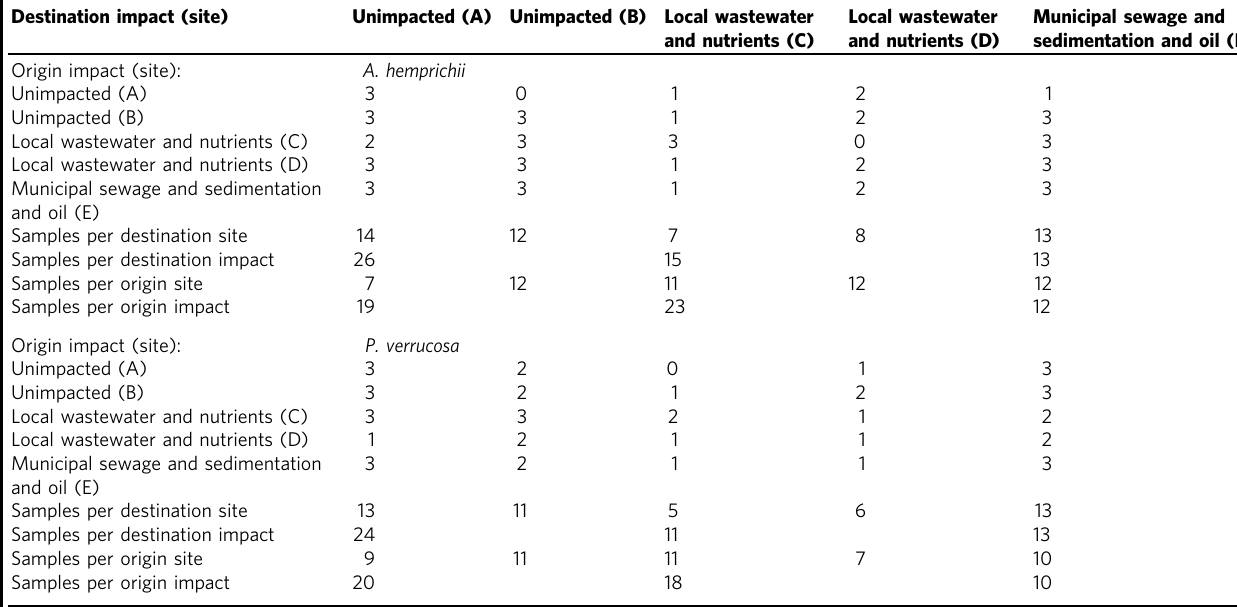
Table 1 Overview of transplanted coral fragments of A . hemprichii and P . verrucosa Destination impact